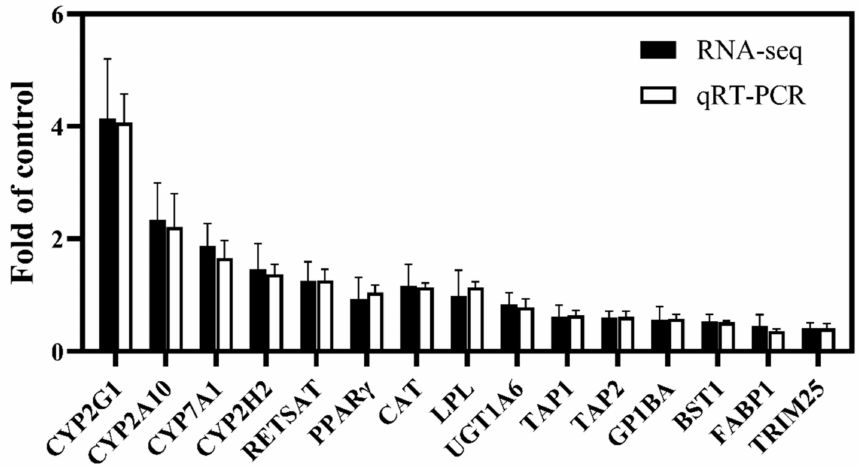
Figure 4. Verification of transcriptome results by